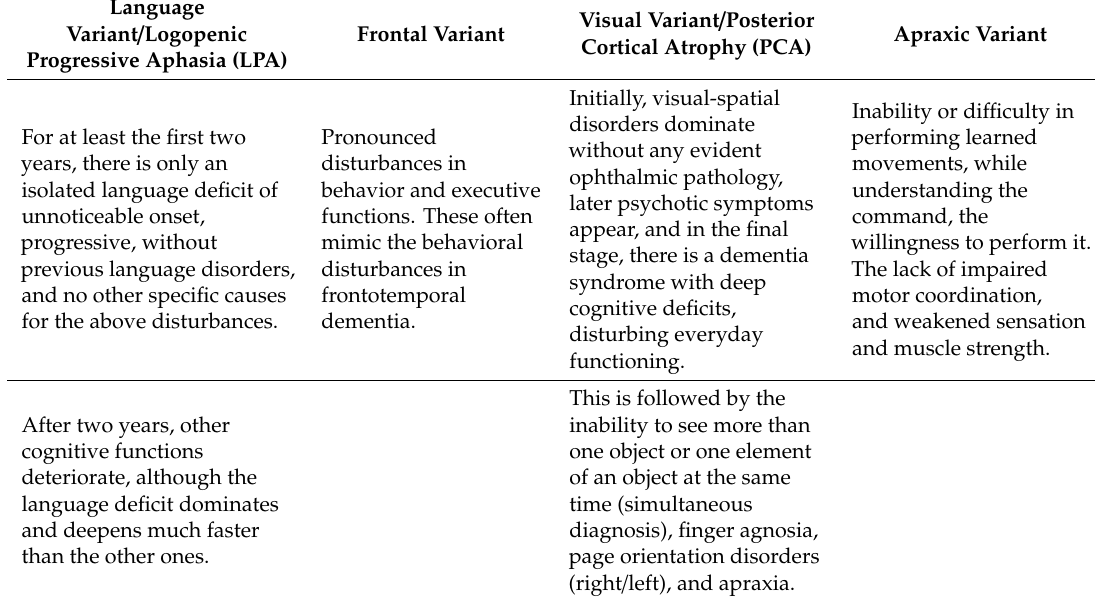
Table 1. Characteristics of symptoms of di ff erent variants of Alzheimer’s disease